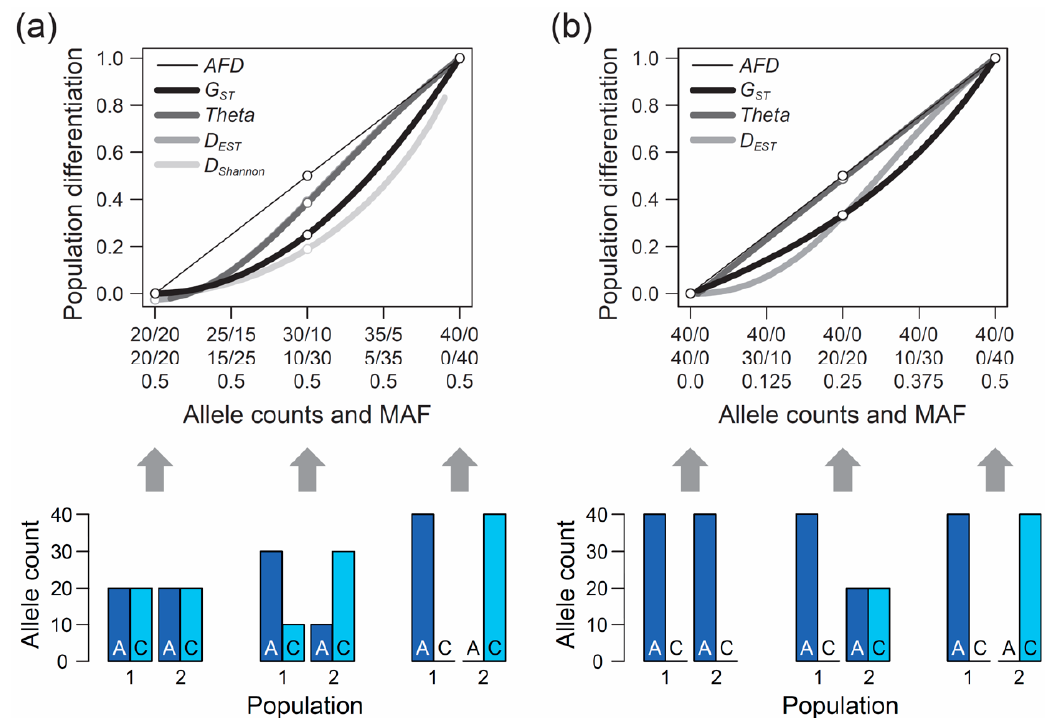
Figure 1. Population differentiation expressed by different metrics. Magnitude of genetic differentiation at a bi-allelic single-nucleotide polymorphism (SNP) along the continuum of allele frequency differentiation between two populations (top graphs). Differentiation is quantified by the absolute allele frequency difference ( AFD ), by two popular estimators of F ST ( G ST and Theta ), by D EST , and by Shannon differentiation ( D Shannon ). The X-axis specifies the underlying allele counts in population 1 (first row) and population 2 (second row) for two hypothetical alleles (A, C), assuming a draw of 40 total alleles per population at the exact allele frequencies in each population (no sampling stochasticity). The third row gives the frequency of the less common SNP allele across the